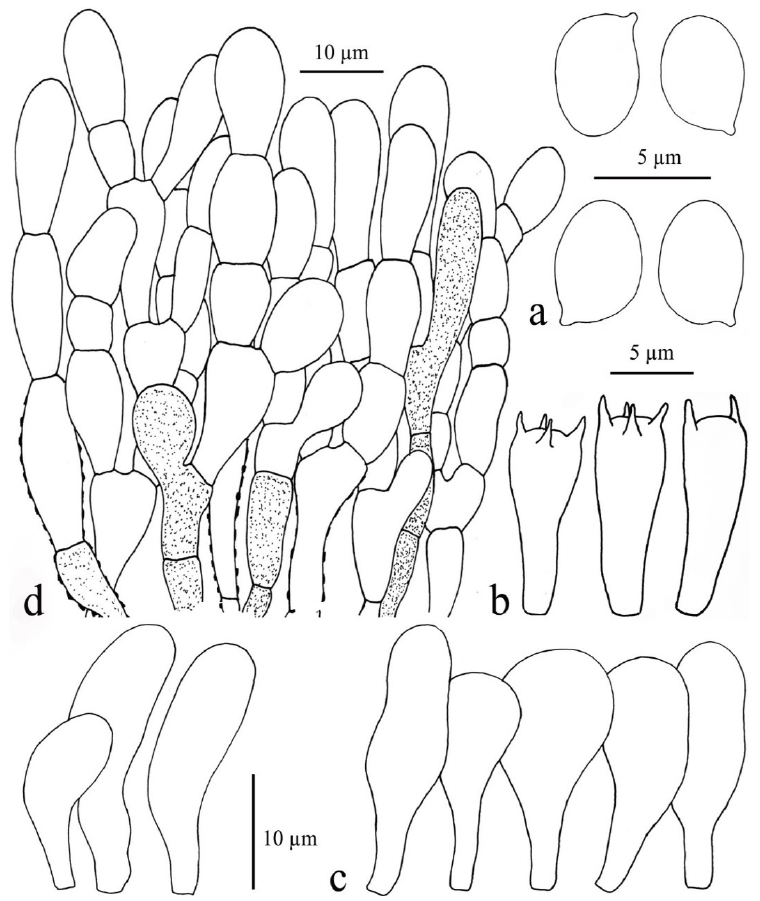
Figure 24. Microcharacters of Pseudolepiota zangmui (MFLU 10-0515). ( a ) basidiospores. ( b ) basidia. ( c ) cheilocystidia. ( d ) pileus covering. Pileus 20–50 mm, at first hemispherical, campanulate, expanding to convex, umbo- nate or often plano-convex with an umbo and inflexed margin; surface covering violet- brown (10F5-8, 11F-8), darker at umbo or center, dark ruby to dark (12F4–8), smooth or rough, later splitting off and becoming irregularly concolorous squamulose, with larger scales around the umbo and with smaller squamules toward the margin, with dull red (9B3–4) fibrillose or fibrillose squamules at the marginal zone on a white to orange-white (6A2) background; squamules are fragile when mature; margin appendiculate, with white to dull red (9B3–4) fibrillose remnants. Lamellae free, at first white, turning yellowish- white when mature and greyish-orange (5B3–4) when dried, 3.5–5 mm wide, crowded, with 4–5 lamellulae in between lamellae, slightly fragile with age, with an eroded edge. Stipe 25–40 × 5–8 mm, equal, slightly wider at base zone, completely covered by white to yellowish-white fibrils, sometimes with white remnants at the annular zone. Annulus a white annular zone. Context white in pileus, up to 4 mm wide, white in the stipe, changing to reddish with age, hollow. Spore print whitish. Taste and smell not observed.